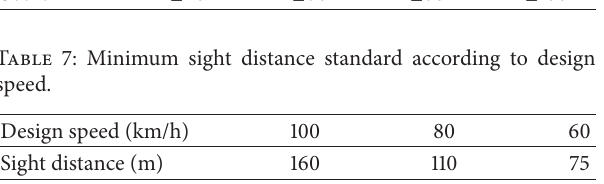
Table 6: Scoring method according to number of curve sections. Relative ratio Under 10%